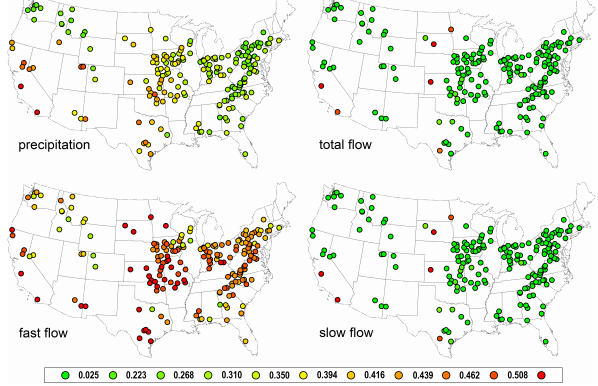
Fig. 5. Regional patterns of variation of α for the different duration curves.